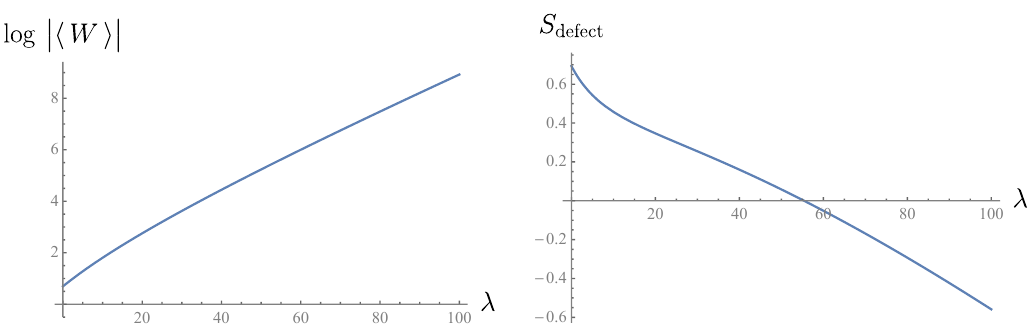
Figure 4 . The defect free energy (Left) and the defect entropy (Right) of the 1/2-BPS Wilson loop in the 4 d N = 4 SYM. The N = 2 cases are shown. The defect free energy is positive for any (cid:21) while the defect entropy can be